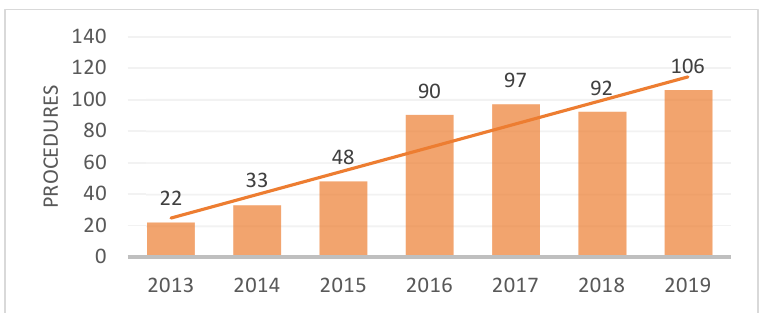
Figure 2. Number of bariatric procedures performed annually.